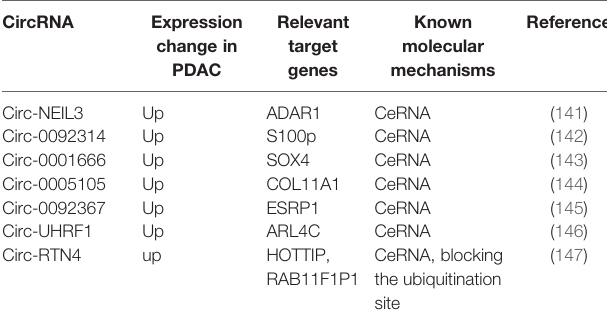
TABLE 2 | CircRNAs in PDAC development through EMT